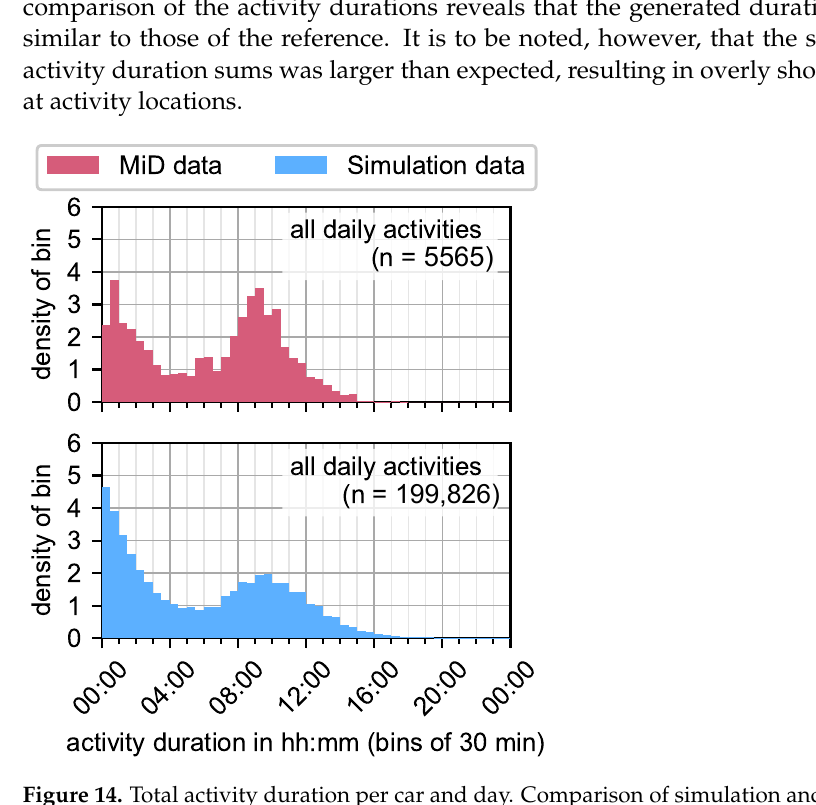
Figure 14. Total activity duration per car and day. Comparison of simulation and